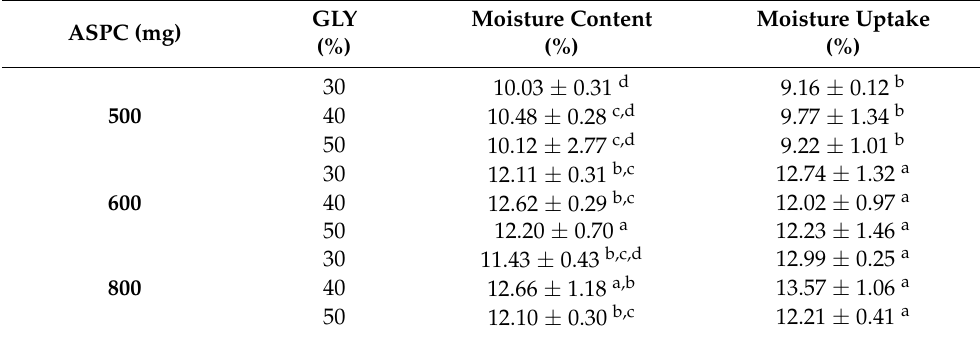
Table 2. Moisture content and uptake of argan seed protein concentrate (ASPC)-based films prepared with different amounts of ASPC and glycerol (GLY). Different superscript letters (a–d) indicate significant differences among the values reported ( p < 0.05). Further experimental details are given in the text. GLY ASPC (mg) (%)